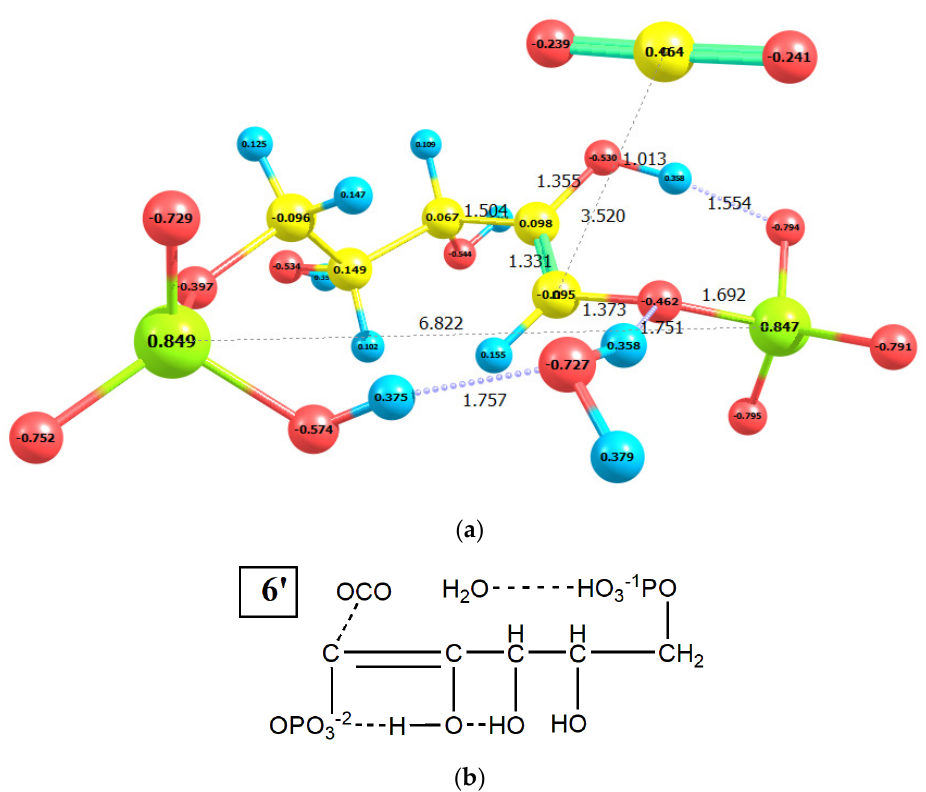
Figure A12. ( a ) The calculated geometric and electronic structures of the initial state of carboxylation in the C1 direction; Q = − 3, M = 1, E 0 = − 53,664.08 eV, G 0 = − 53,659.65 eV. Hessian has no negative frequencies. ( b ) The scheme of state (6 ′ ) is pictured in Figure 5b.